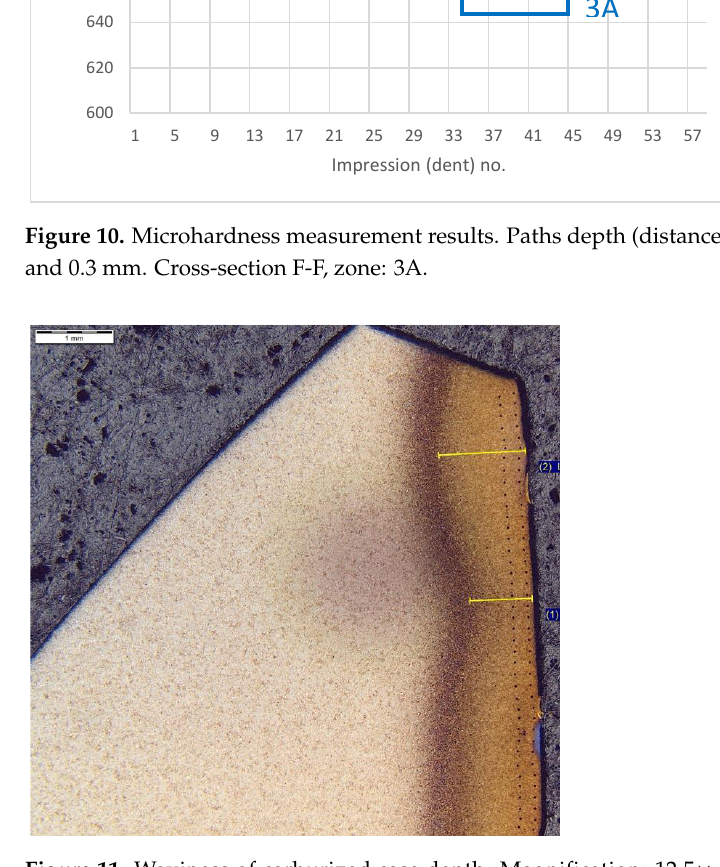
Figure 11. Waviness of carburized case depth. Magnification: 12.5×. Cross-section F-F, zone: 3A. Etched sample — Nital